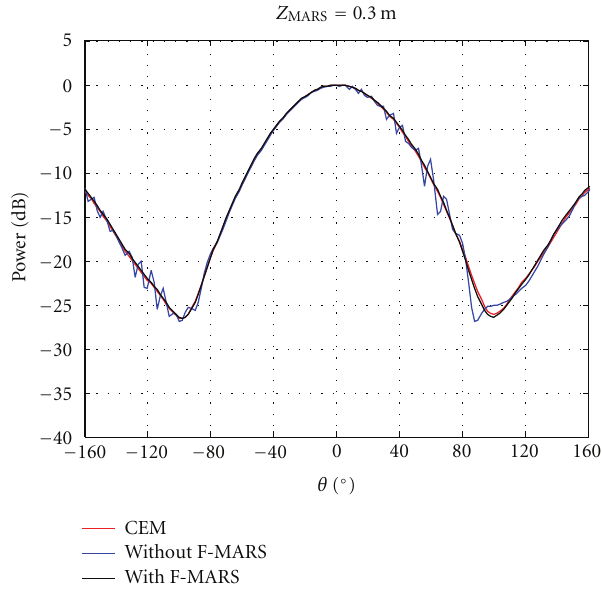
Figure 15: Far-field cut with and without MARS processing. Dis- placement of 30